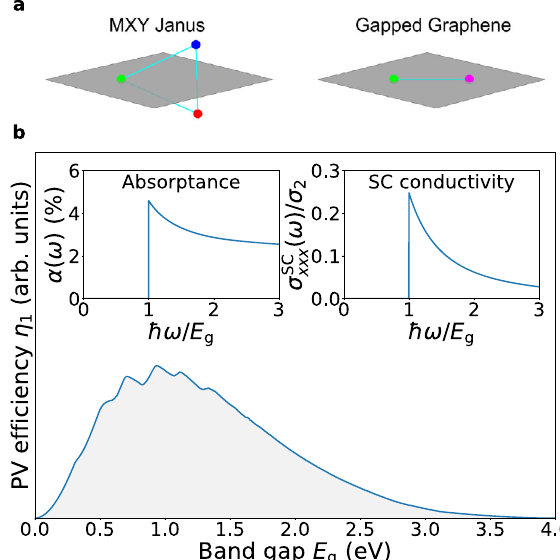
Fig. 7 Absorptance, SC conductivity, and ef fi ciency of gapped graphene. a Unit cells of MXY Janus structure and gapped graphene. b PV ef fi ciency vs. band gap for gapped graphene, as given by Eq. (17). Insets: Absorptance and SC conductivity spectra for gapped graphene, as given by Eqs. (15) and (16), respectively, with line width set to